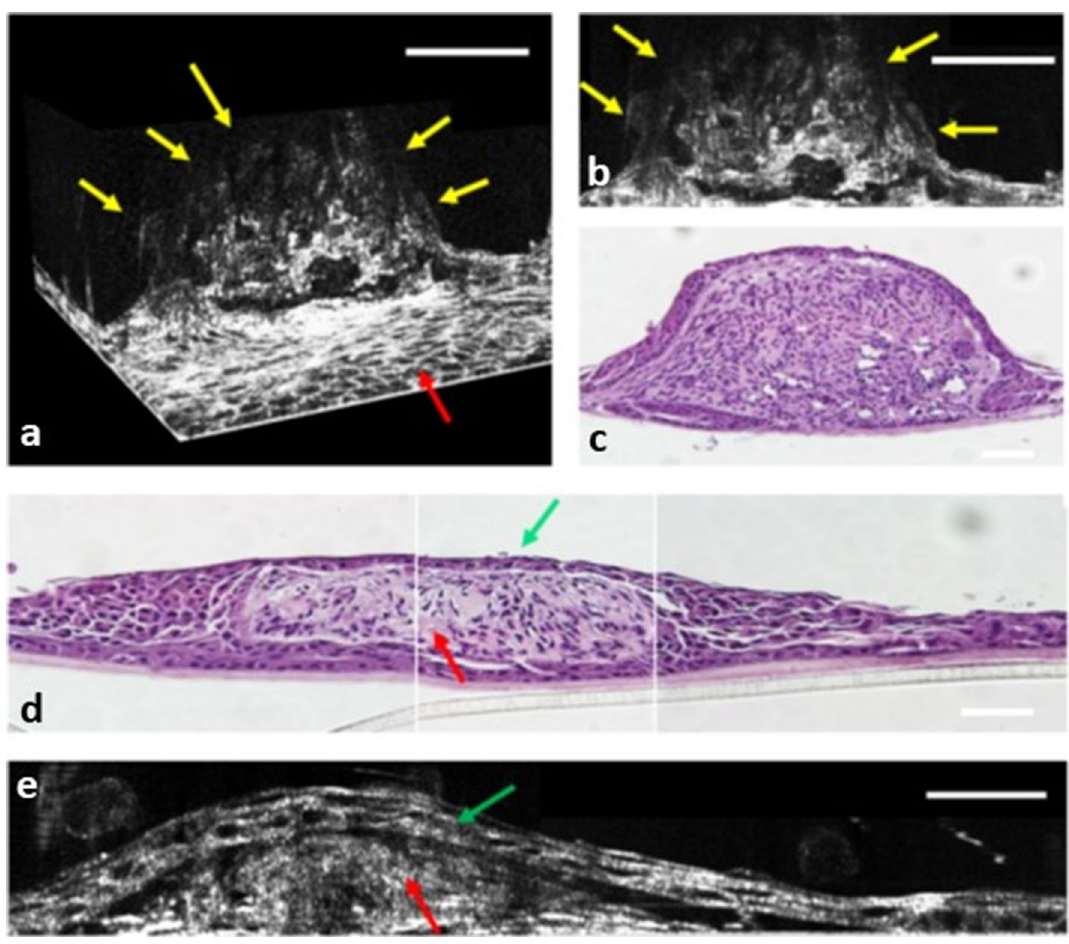
Figure 6. The histological, 3D, and 2D cross-sectional FF-OCT images of multilayered cultivated cell sheets. ( a ) FF-OCT 3D images of DACNs. Yellow arrows indicate the outline surface of DACNs. Red arrows indicate the epithelial type of cells spread at the bottom of DACNs. ( b ) FF-OCT 2D images of DACNs. Yellow arrows indicate the outline surface of DACNs. ( c , d ) Hematoxylin and eosin (H&E) staining of cross-sectional DACNs revealed two different cell types, with epithelial cells covering the entire superficial surface of the colonies of neuron-like cells. ( e ) A 2D cross-sectional FF-OCT images of DACNs demonstrated epithelial-like cells covering the surface of neuron-like cells. ( d , e ) Green arrows indicated superficial epithelial cells. Red arrows indicated neuron-like cells. ( a , b ) Scale bar = 100 μm. ( c ) scale bar = 50 μm. ( d , e ) scale bar = 25 μm. DACN: directly adherent colonies of neuron-like